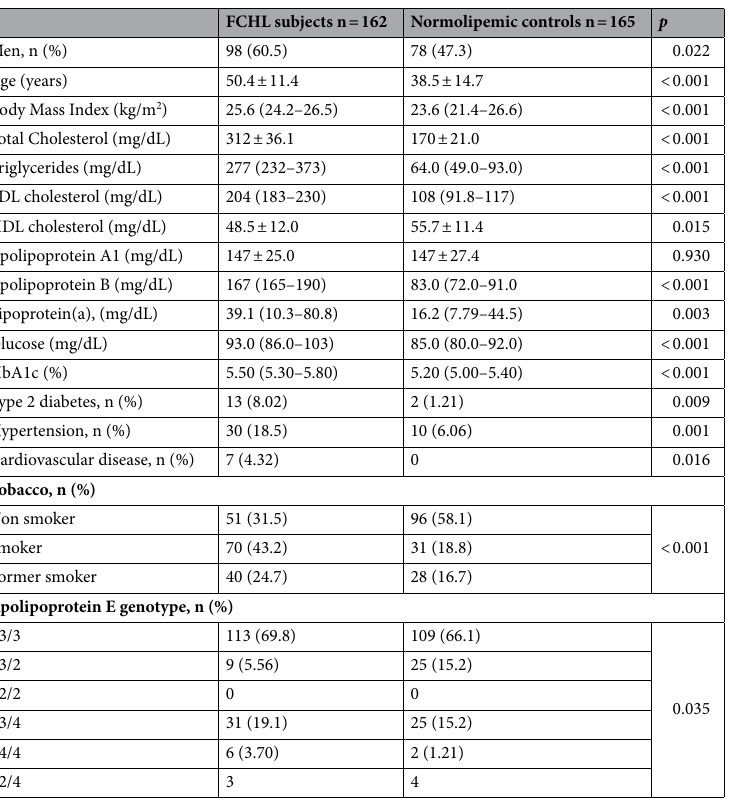
Table 2. Clinical and biochemical characteristics in FCHL subjects and normolipemic controls. Quantitative continuous variables are expressed as mean ± standard deviation or median [percentile 25–75]. Student’s t or Mann–Whitney tests were used to assess differences between two groups. Quantitative categorical variables are expressed as n (%) and statistical differences were assessed by